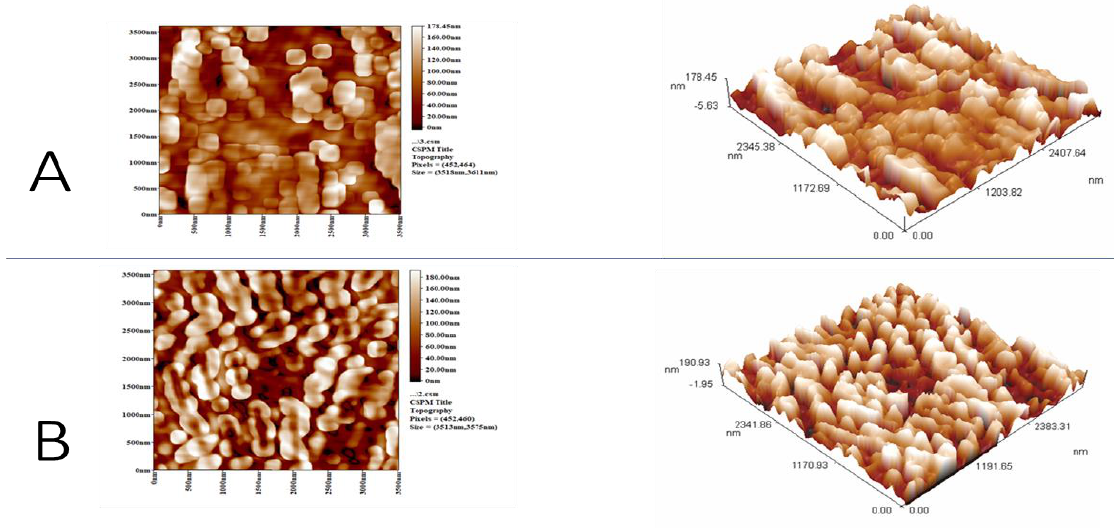
Figure 1 : AFM micrographs, 3 D and 2D graphs for the average roughness of specimen. A. AFM micrographs for PEKK, B. AFM micrographs for PEKK coating with SR HA